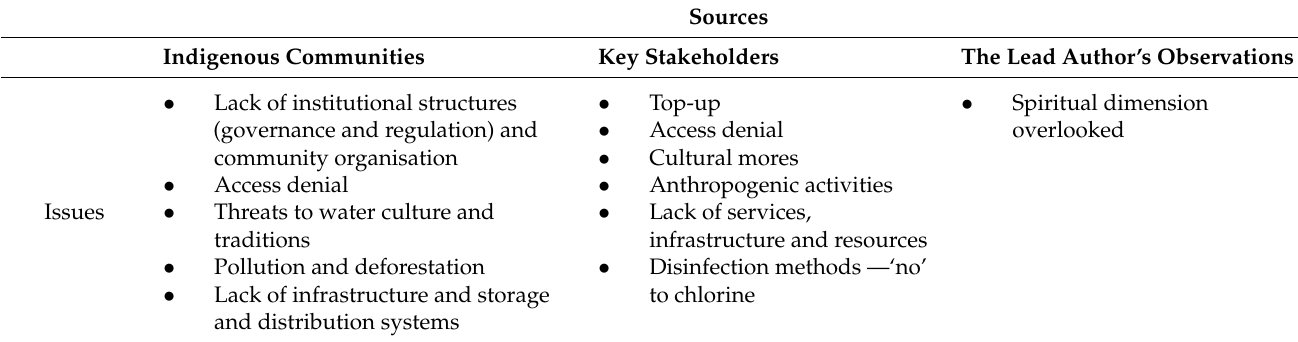
Table 2. Issues impacting availability and access to safe water from different